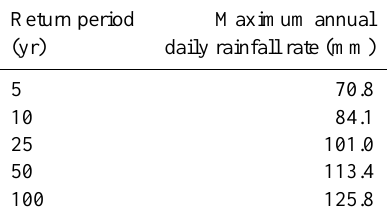
Table 6. Reference costs for estimating potential economic